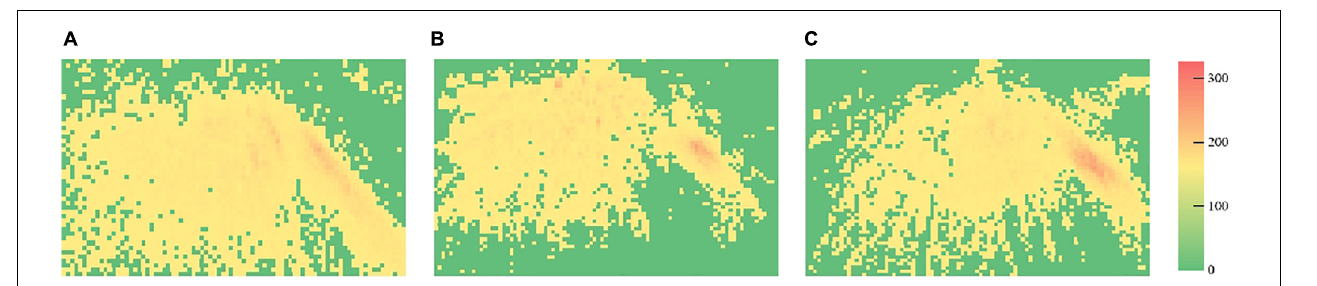
FIGURE 6 | Heat maps of course 1 ( A , heat map of subject 1; B , heat map of subject 2; and C , heat map of subject 3).